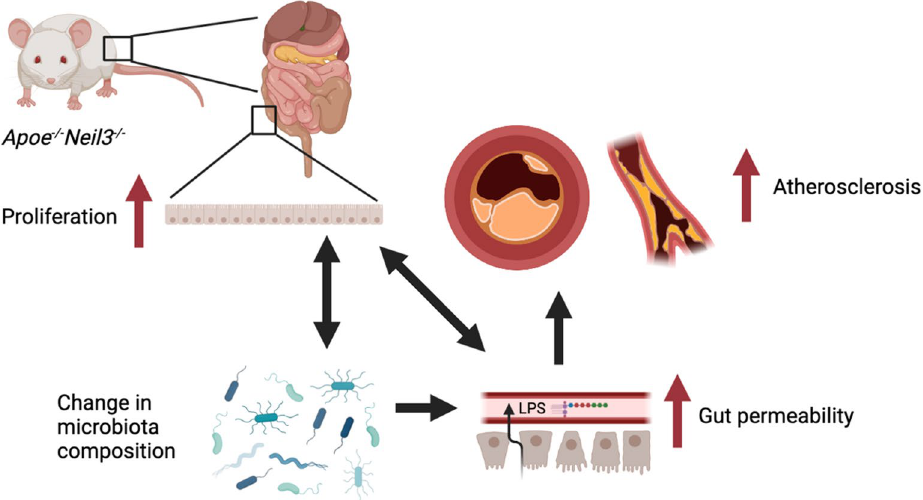
Figure 7. Graphical abstract. Our results show increased proliferation of colon epithelial cells, altered gut microbiota composition and increased gut permeability in young Apoe −/− Neil3 −/− mice as compared to Apoe −/− mice. We suggest these findings as drivers of accelerated atherosclerosis development which these mice develop with age. Figure created with